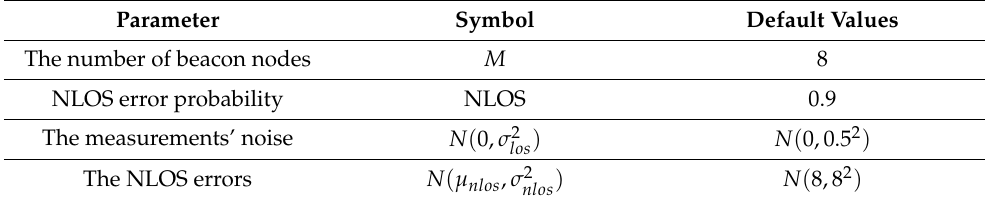
Table 1. Gaussian distribution parameter map.